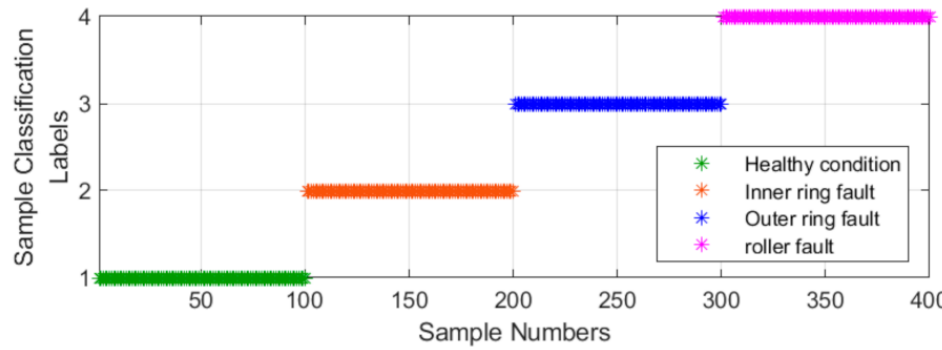
Figure 14. 400 samples and their corresponding classification labels.